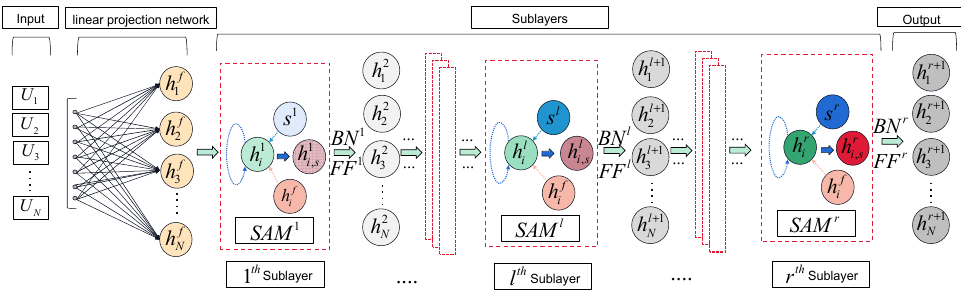
Figure 3. Process of the